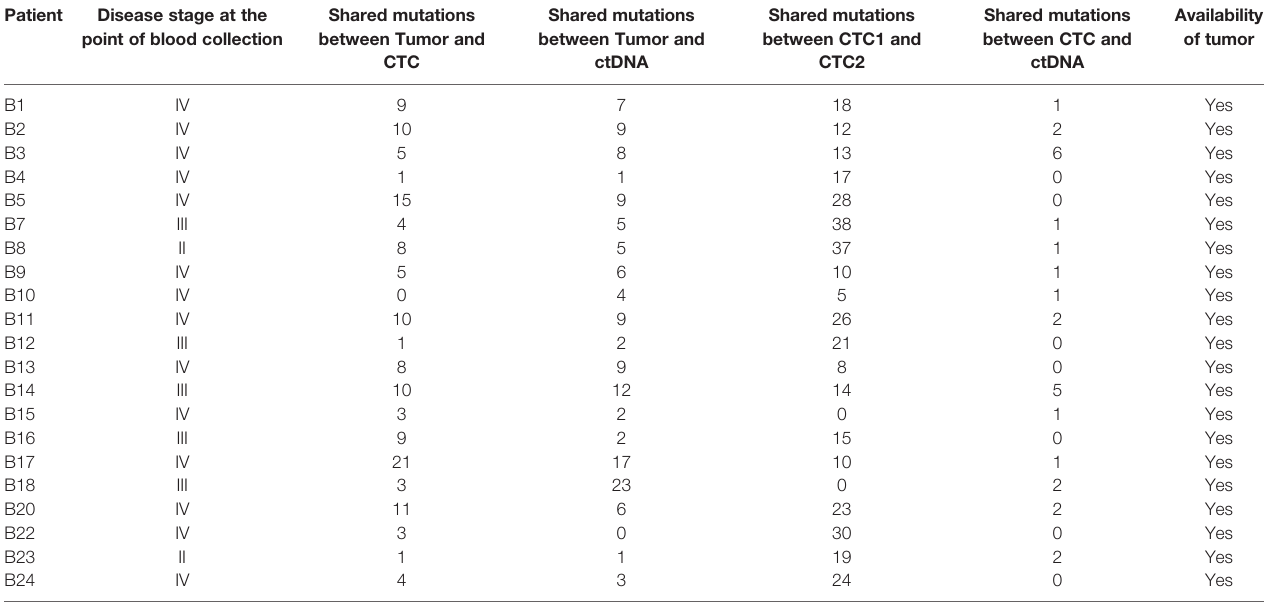
TABLE 4 | The tabulation of all the detected mutations that are shared between tumor, CTCs and ctDNA in regardless of the differential time points for the breast cancer samples. Patient Disease stage at the point of blood